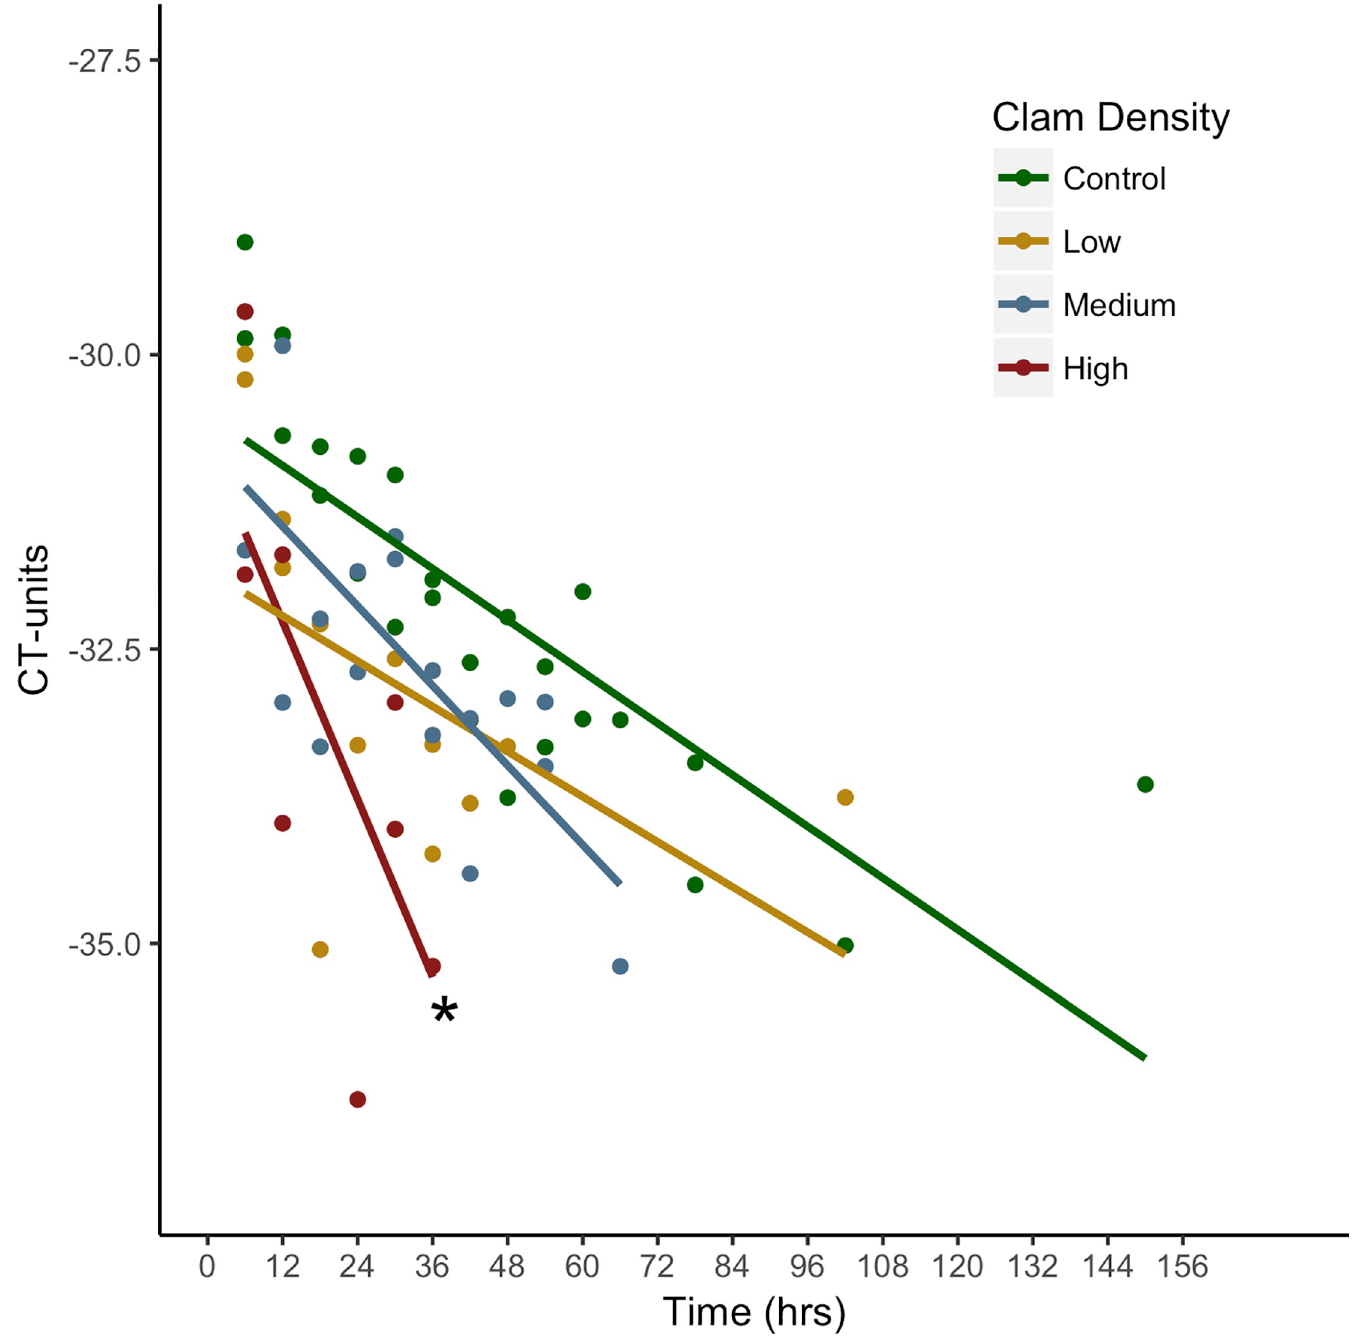
Fig 1. Concentration of DNA (in CT-units) across treatment densities over time. CT-units measured at each timestep across four treatment densities (Control = 0 clams/m 2 , Low = 102.56 clams/m 2 , Medium = 307.69 clams/m 2 , and High = 679.49 clams/m 2 ). Asterisk ( � ) denotes significantly different slope compared to all other treatment densities. (n =